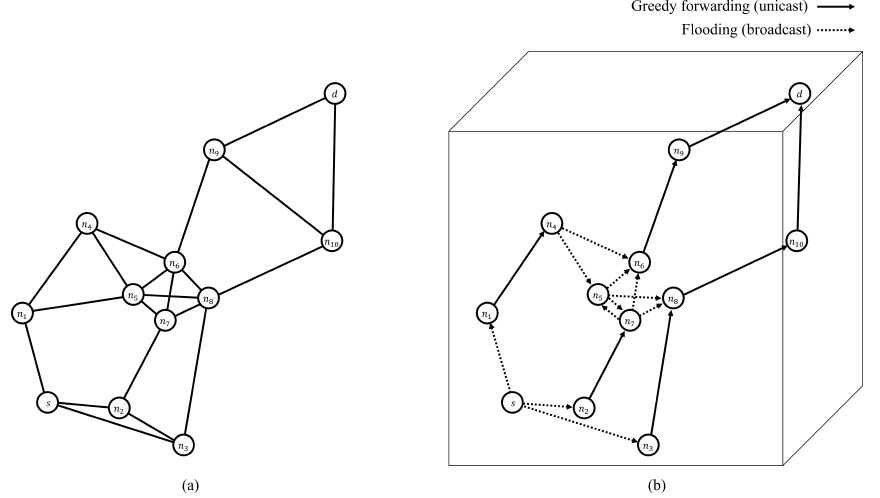
Figure 10. Example of P2P route discovery case for explanation of adaptive listen-only periods operation in adaptive trickle timer. ( a ) The network node deployment and node connectivity. Nodes s and d are the source and destination, respectively. Nodes s , n 4 , n 5 and n 7 are void nodes. ( b ) P2P-DIO messages are greedily forwarded through the solid arrows and flooded through the dashed